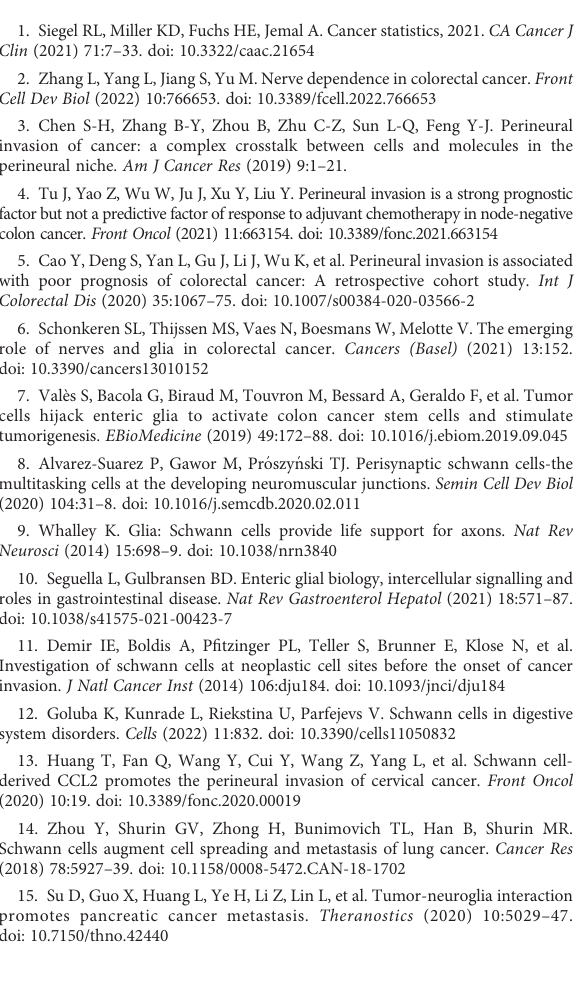
SUPPLEMENTARY FIGURE 1 Schematicdiagram of the co-culture systemandthe generationof CMs. (A) The process of SCs-CM collection. (B) The process of co-culture of SCs and HCT-116 or HT-29 cells and the collection of Schwann cells (Co-HCT-116)-CM or Schwann cells (Co-HT-29)-CM. SC, Schwann